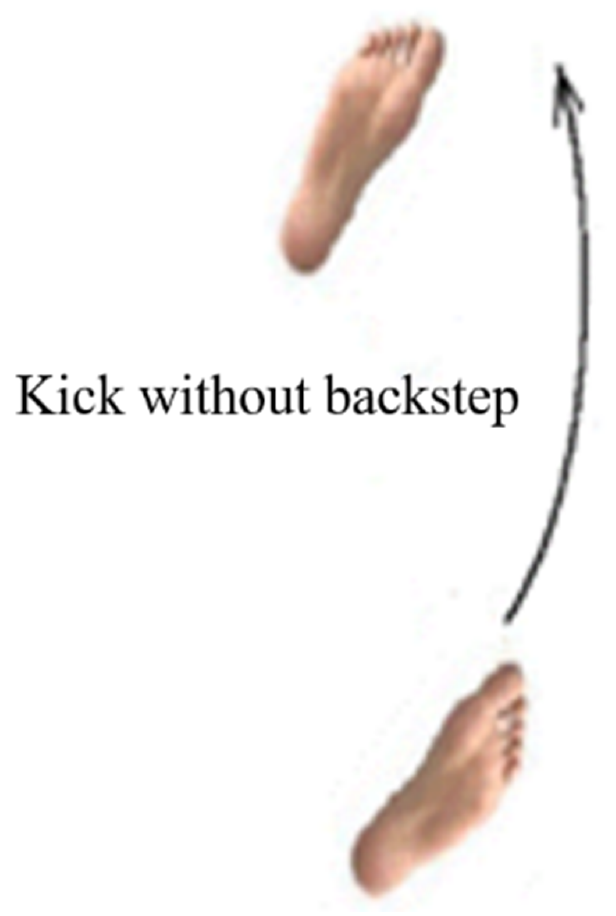
Figure 2. The roundhouse kick without Figure 2 . The roundhouse kick without backstep.